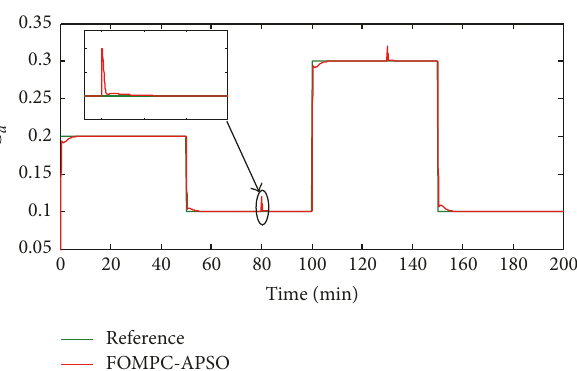
Figure 9: Evolution of control 𝑞 𝑐 .